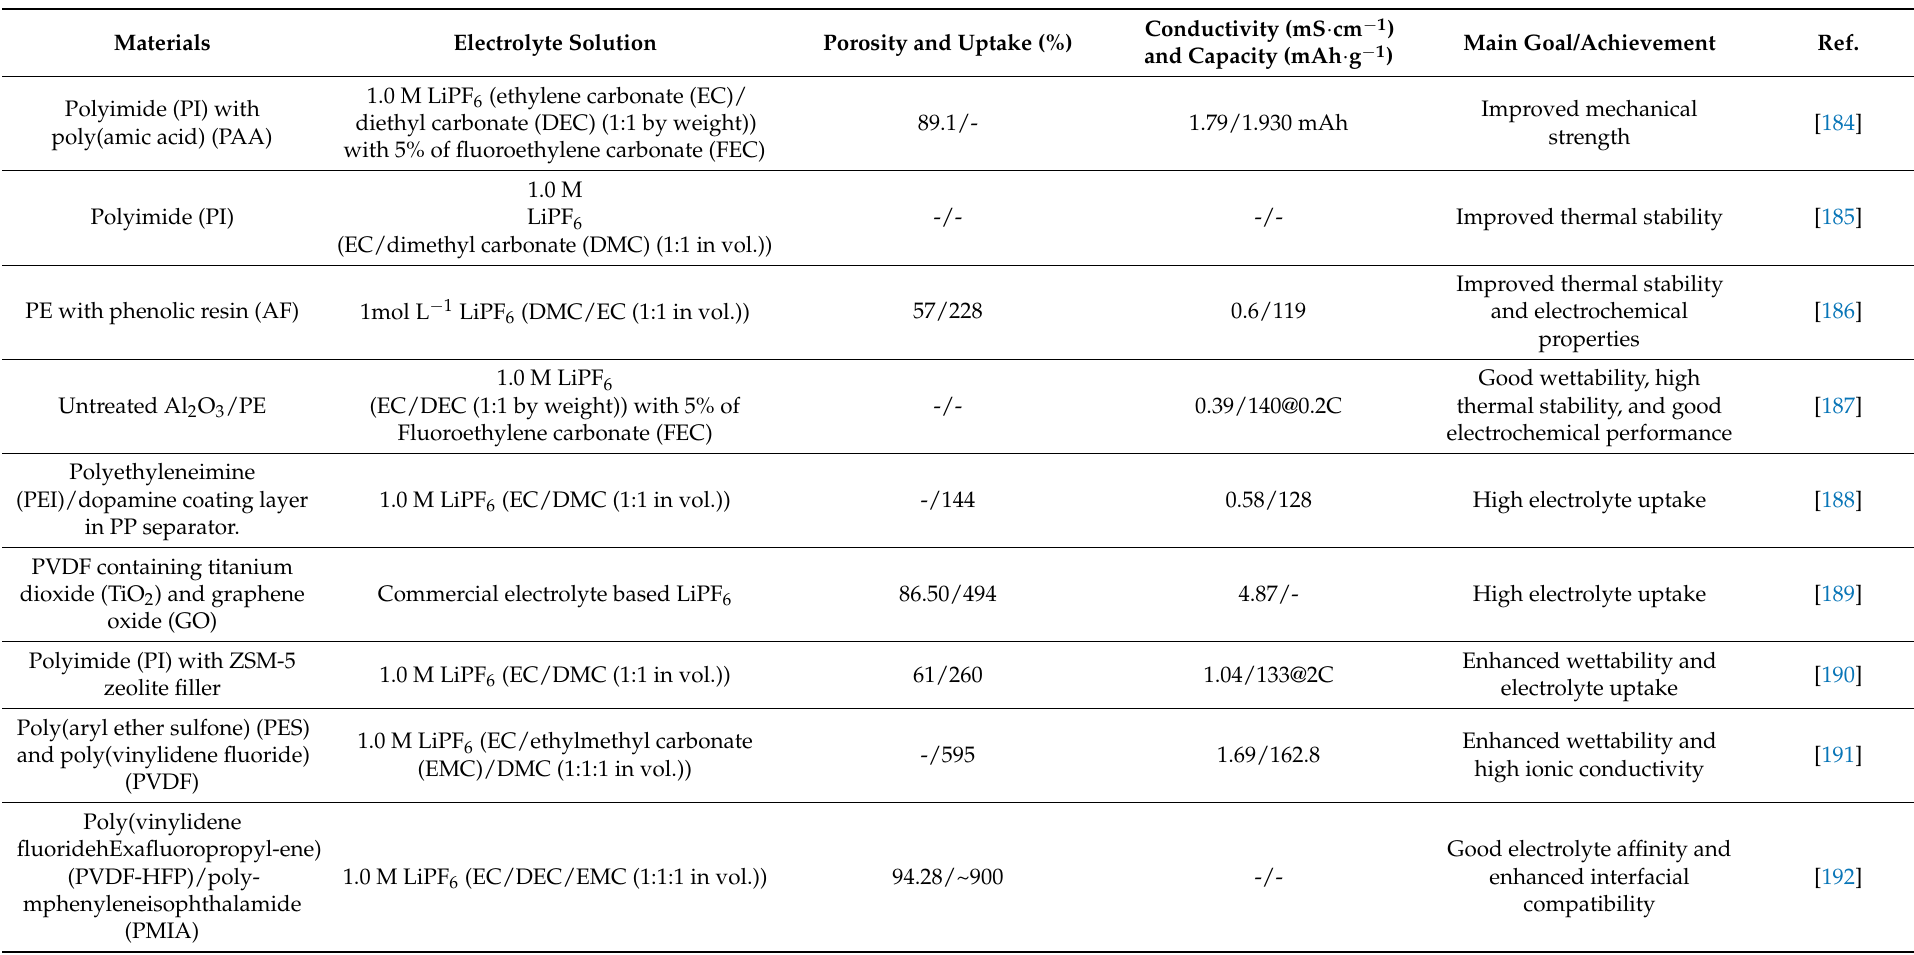
Table 3. Recent advances on Li-ion battery separators based of different materials with main properties, goals and achievements for improving separator characteristics.